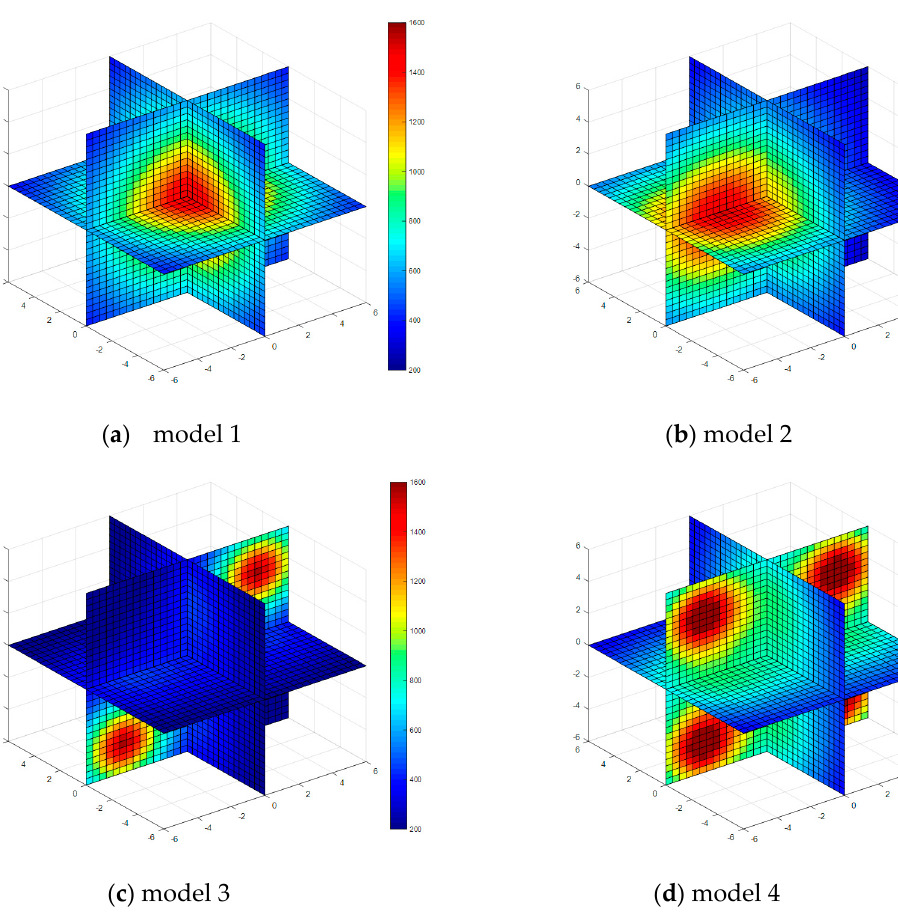
Figure 3. Diagrams of model temperature fields.